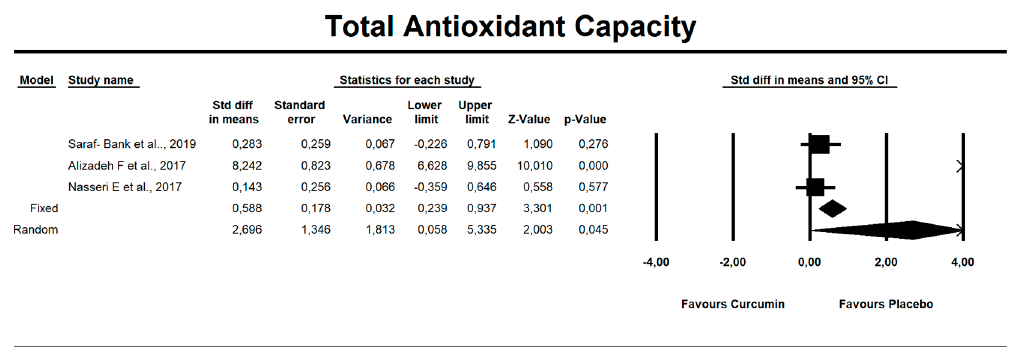
Figure 2. An effect size standardized mean difference, for MDA at endpoint in persons taking curcumin vs. controls (endpoint data). Q = 53.330, df(Q) = 2, p = 0.000, I-squared = 96.250.